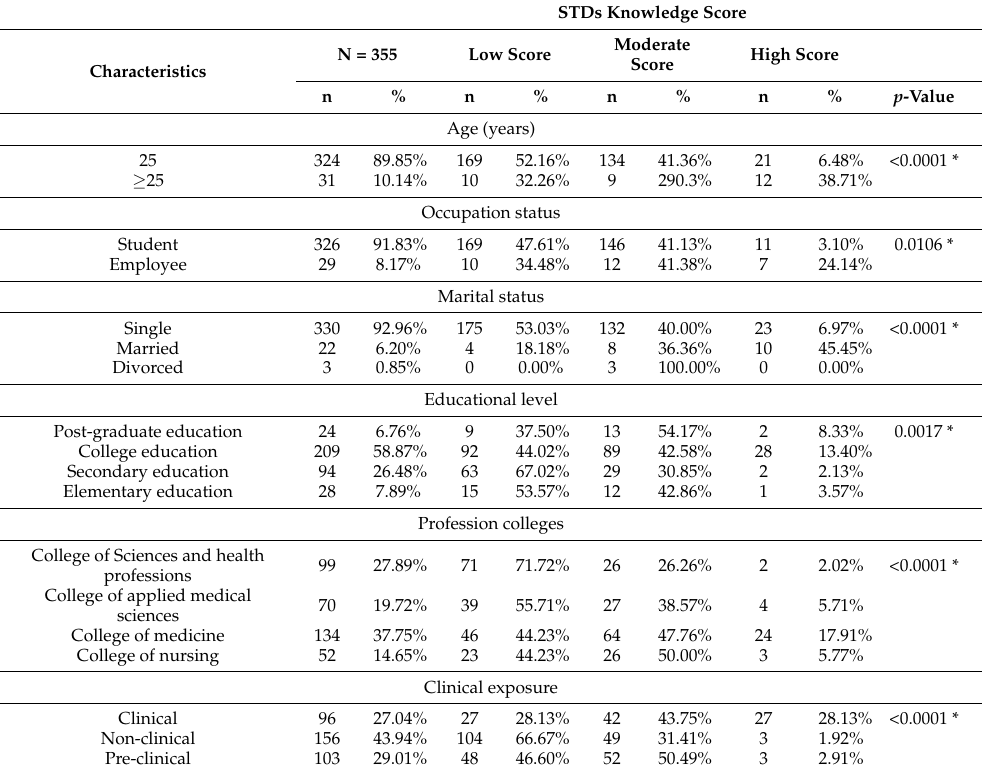
Table 2. Essential study characteristics and their association with STD knowledge score (n =